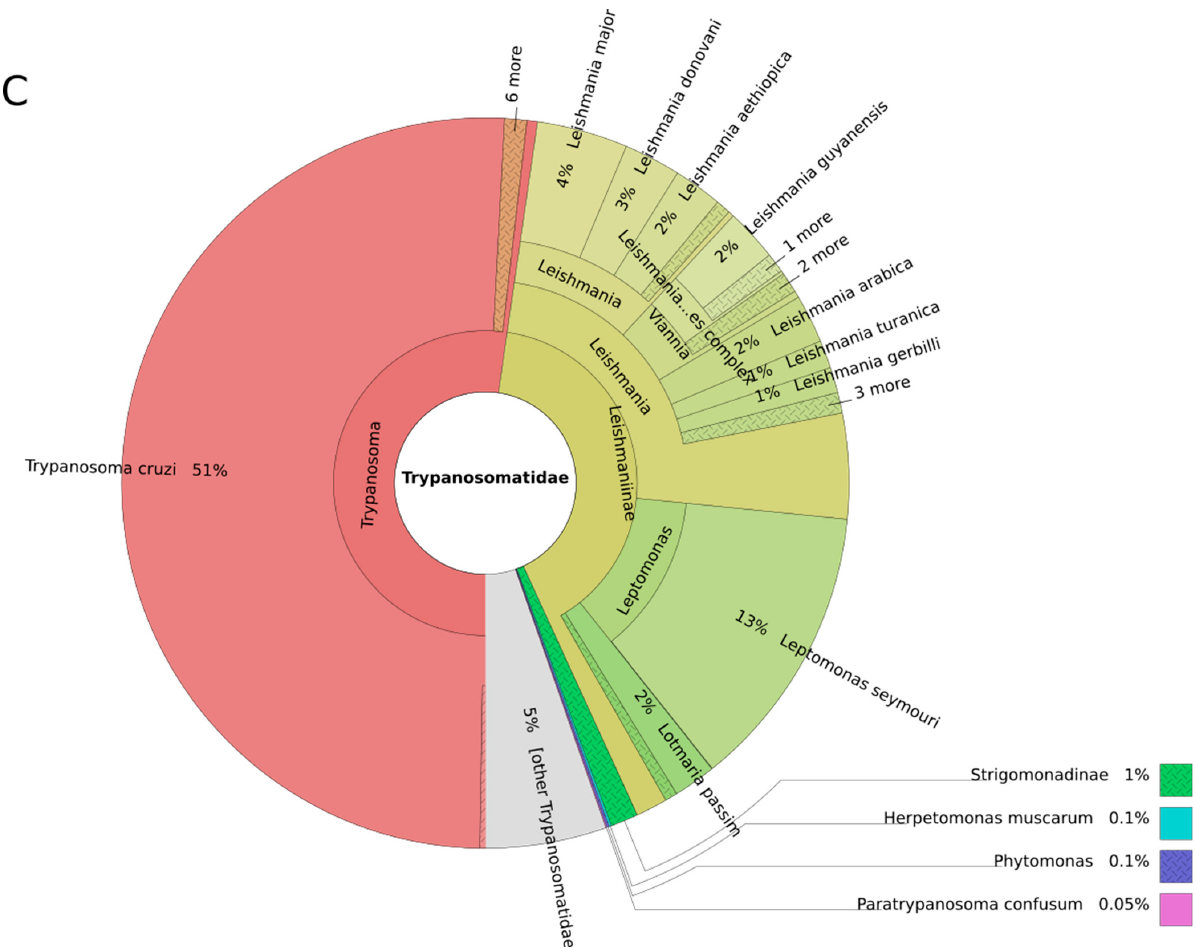
Figure 3. Profiles of microbiomes from three Andean mummies [1]: FI3, FI9, and FI12, for Trypanosomatidae . Circles represent taxonomic classification in ascending order up to the species level (outermost circle) with their relative abundance. These graphs were generated using the program Krona. Less abundant taxa are listed outside the charts.